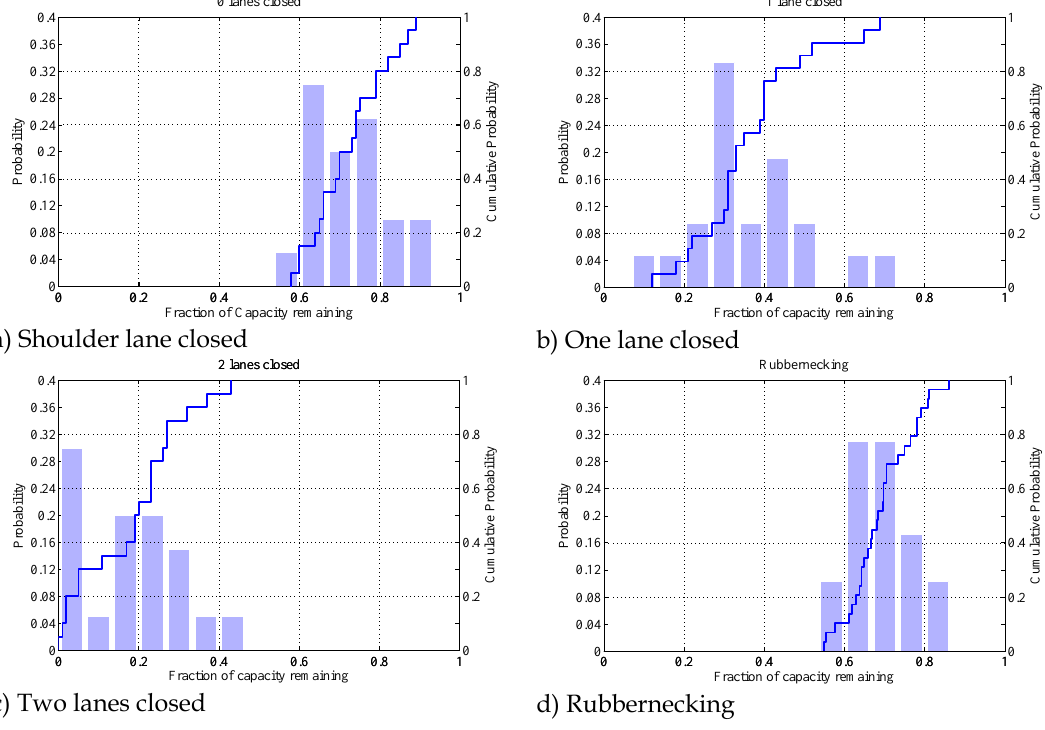
Figure 4. The capacity factor for the three types of incidents which block the roadway and for the rubbernecking Table 5. The resulting capacity factors F Type of